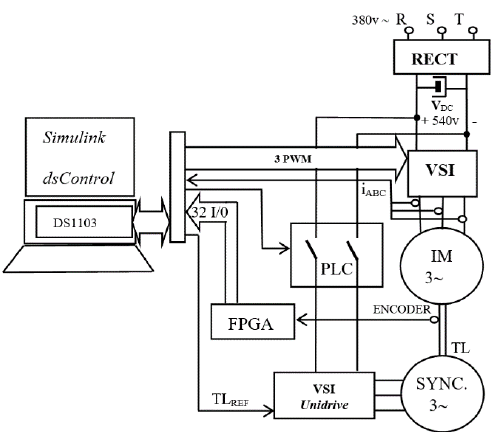
Figure 3. The Blocks diagram of the IM experimental